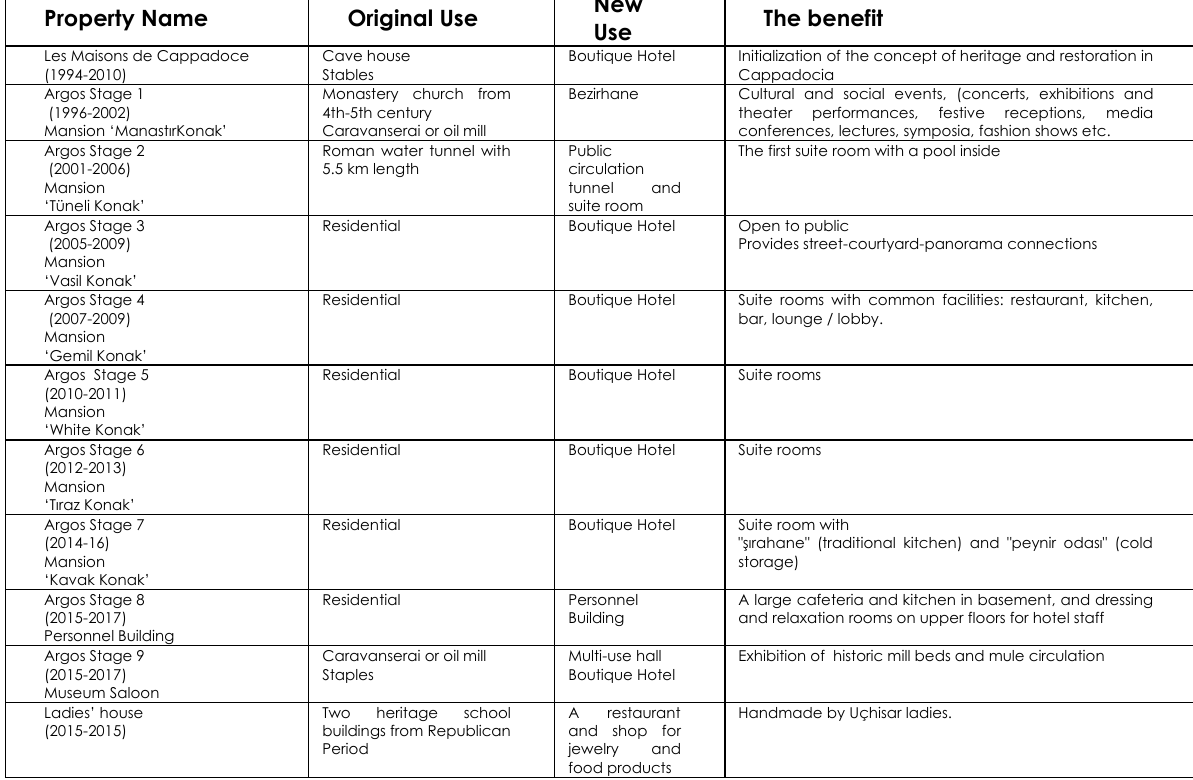
Table 4. Adaptive Re-use Scenarios (Developed by Authors based on info at ( Argos Yapi 2019 ). Property Name